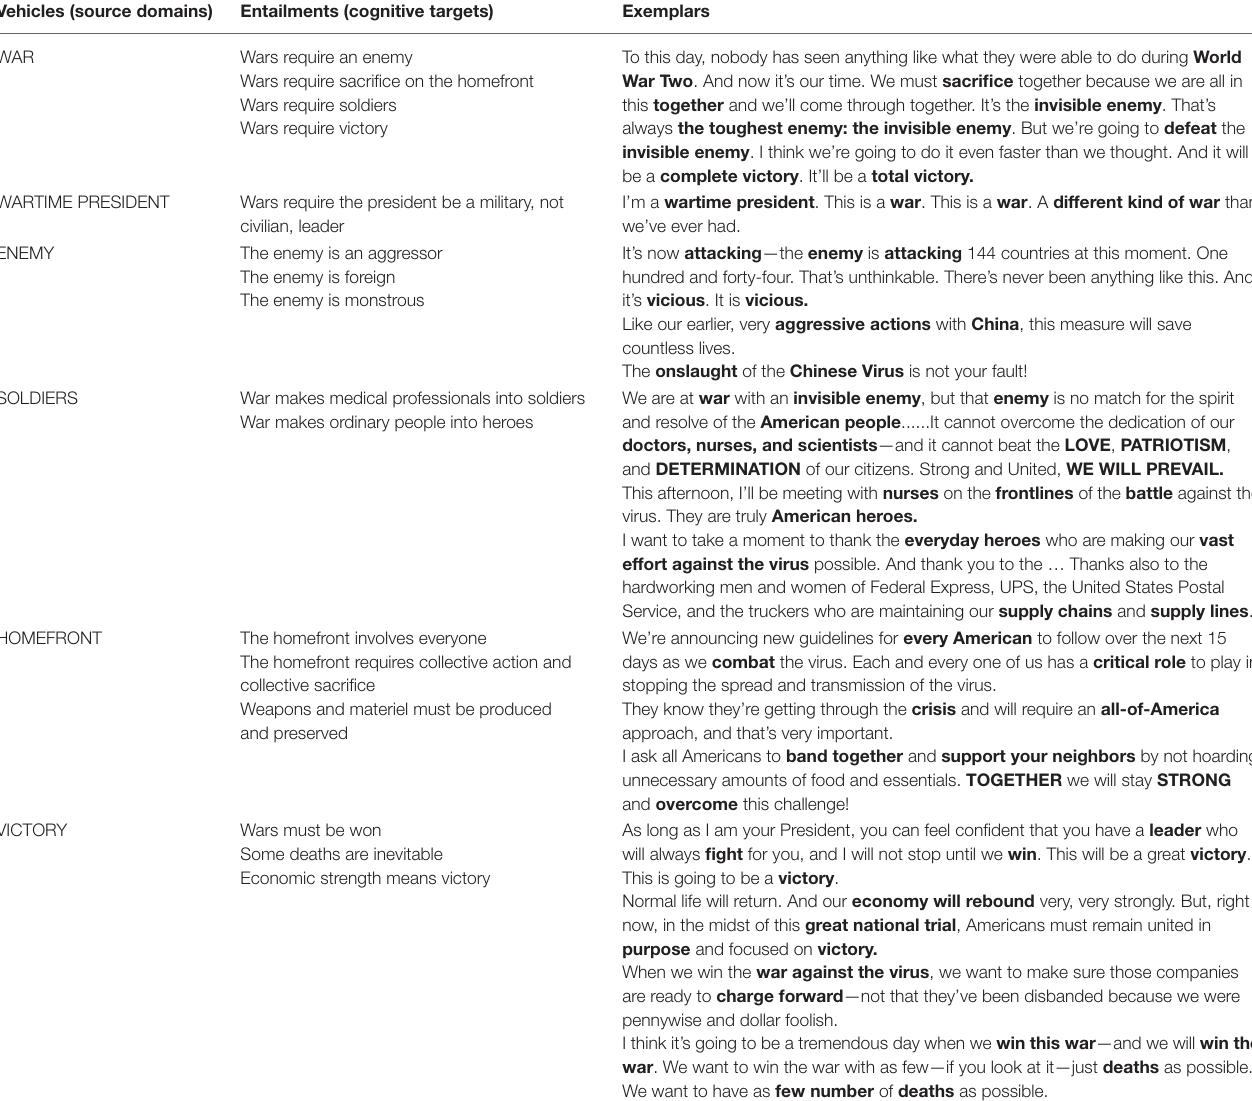
TABLE 1 | Metaphor clusters emergent in Donald Trump’s rhetoric. Vehicles (source